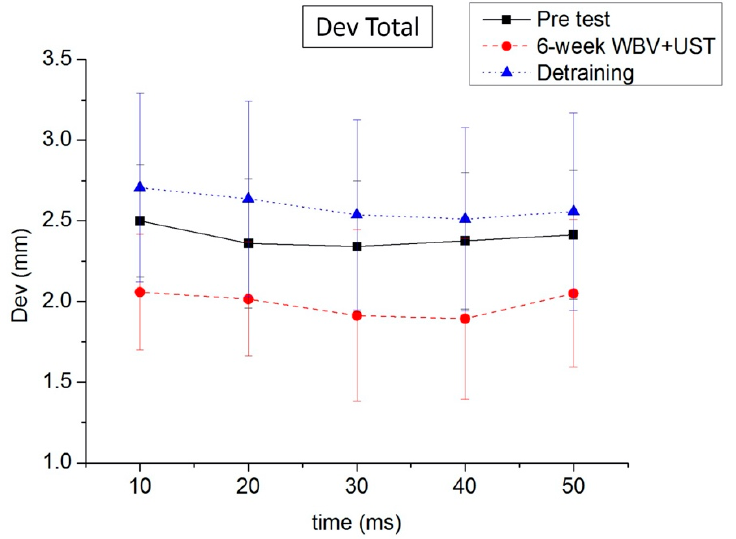
Figure 3. The difference phase during 10–50 ms-DevTotal of the shooting performance.